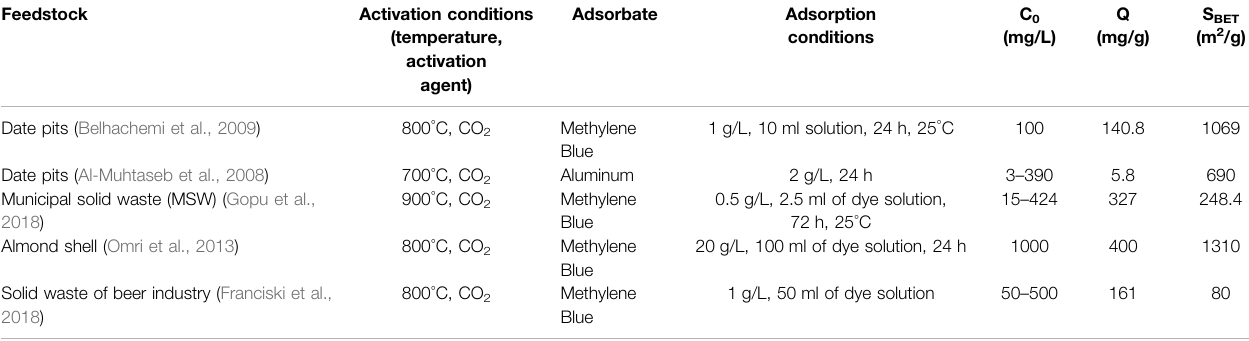
TABLE 1 | Comparison of adsorption capacity of methylene blue using activated biochar from different types of biomass. Feedstock